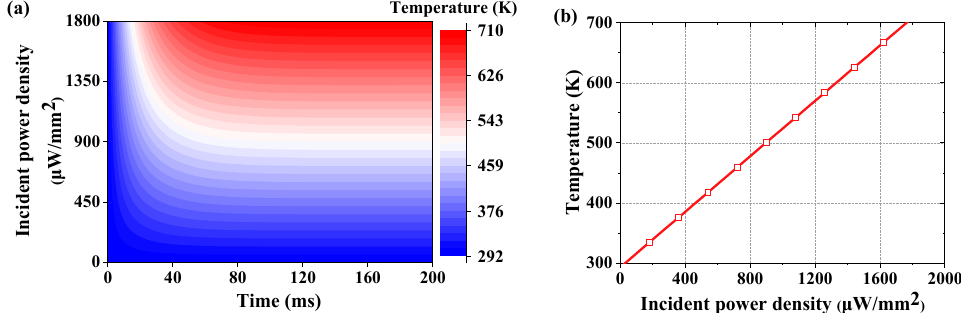
Figure 6. The simulated absorption spectra with ( a ) different polarization angles or ( b ) different incident angles.